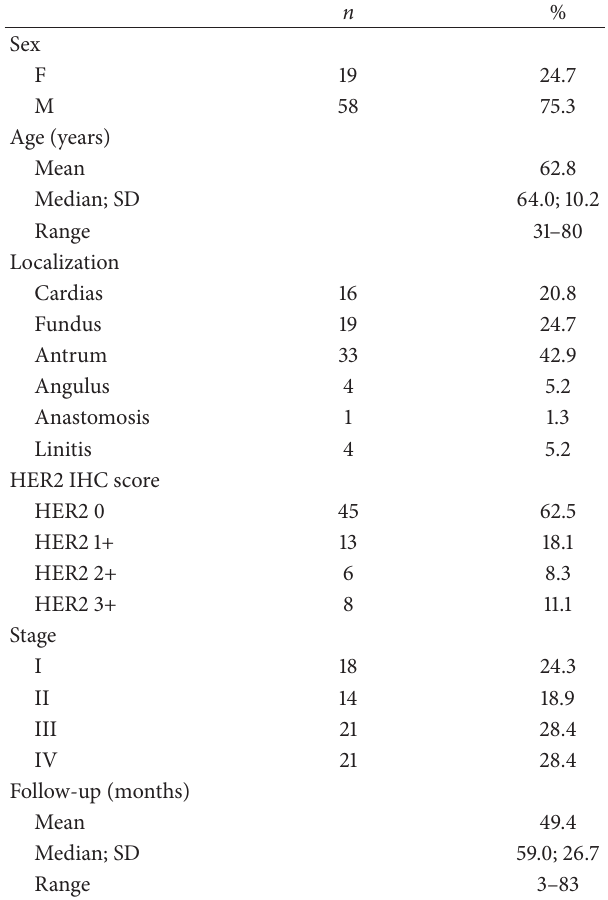
Table 1: Clinical and pathological features of patients who have undergone IHC evaluation for HER2 overexpression in gastric adenocarcinoma from 2003 to